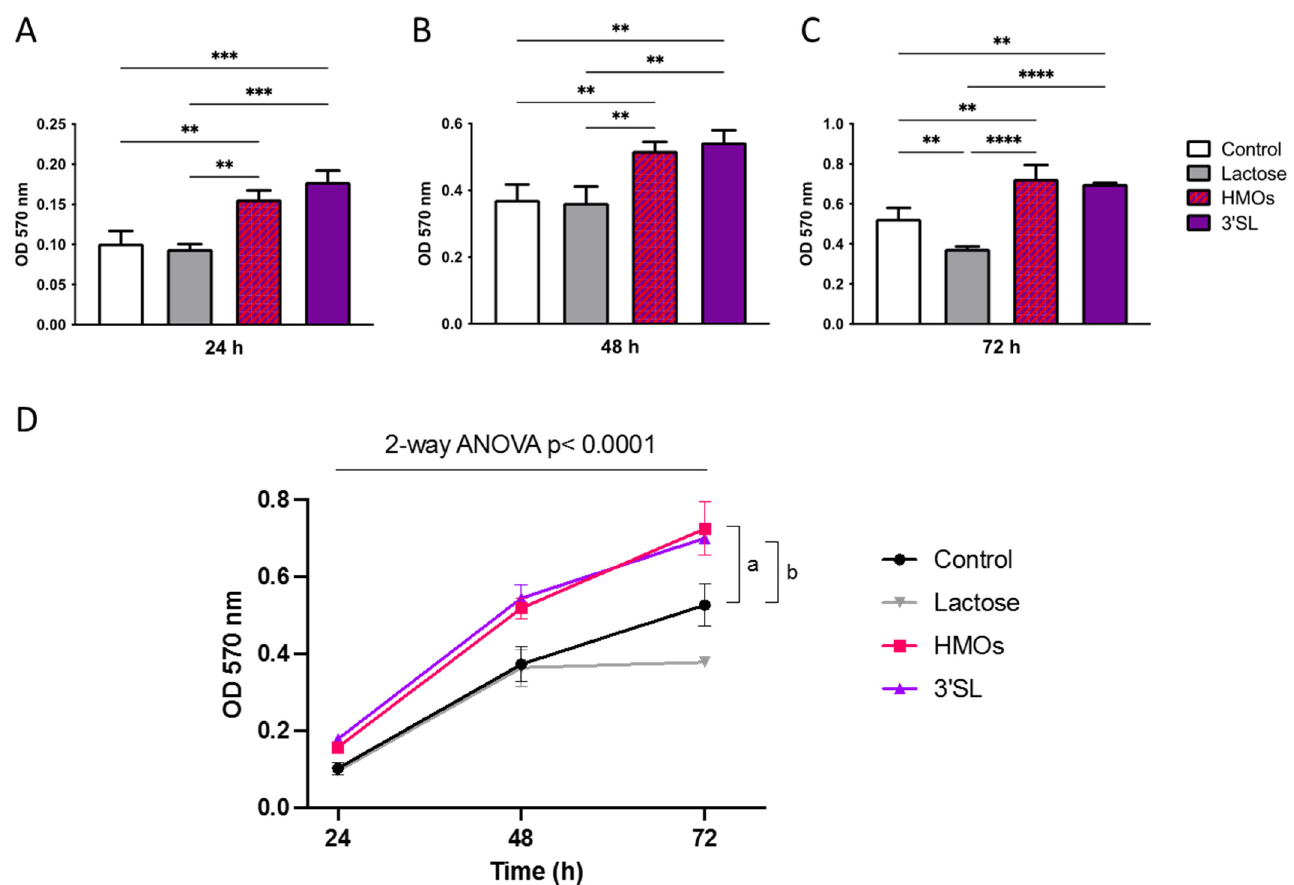
Figure 3. Human milk oligosaccharides (HMOs) increased proliferation of fpECs. The 5 × 10 4 fpECs were resuspended in medium with and without HMOs, 3 ′ SL or lactose, and seeded into wells of a 96-well-plate. MTT dye was added at the indicated time points, and fpECs were incubated for 4 h before the reaction was terminated. Cell viability was determined by measuring the optical density (OD) at 570 nm in an enzyme-linked-immunosorbent assay (ELISA) microplate reader after ( A ) 24, ( B ) 48 and ( C ) 72 h post seeding. Asterisks indicate significant differences between treatments; ** p < 0.01, *** p < 0.001 and **** p < 0.0001. ( D ) Time course of OD at the above shown individual time points (24, 48 and 72 h). Values shown are the mean ± SEM of three different fpEC isolations, each seeded in triplicates. Two-way ANOVA with two-stage Benjamini, Krieger and Yekutieli FDR procedure; the letter a indicates significant difference of HMOs vs. control; the letter b indicates significant difference of 3 ′ SL vs. control.